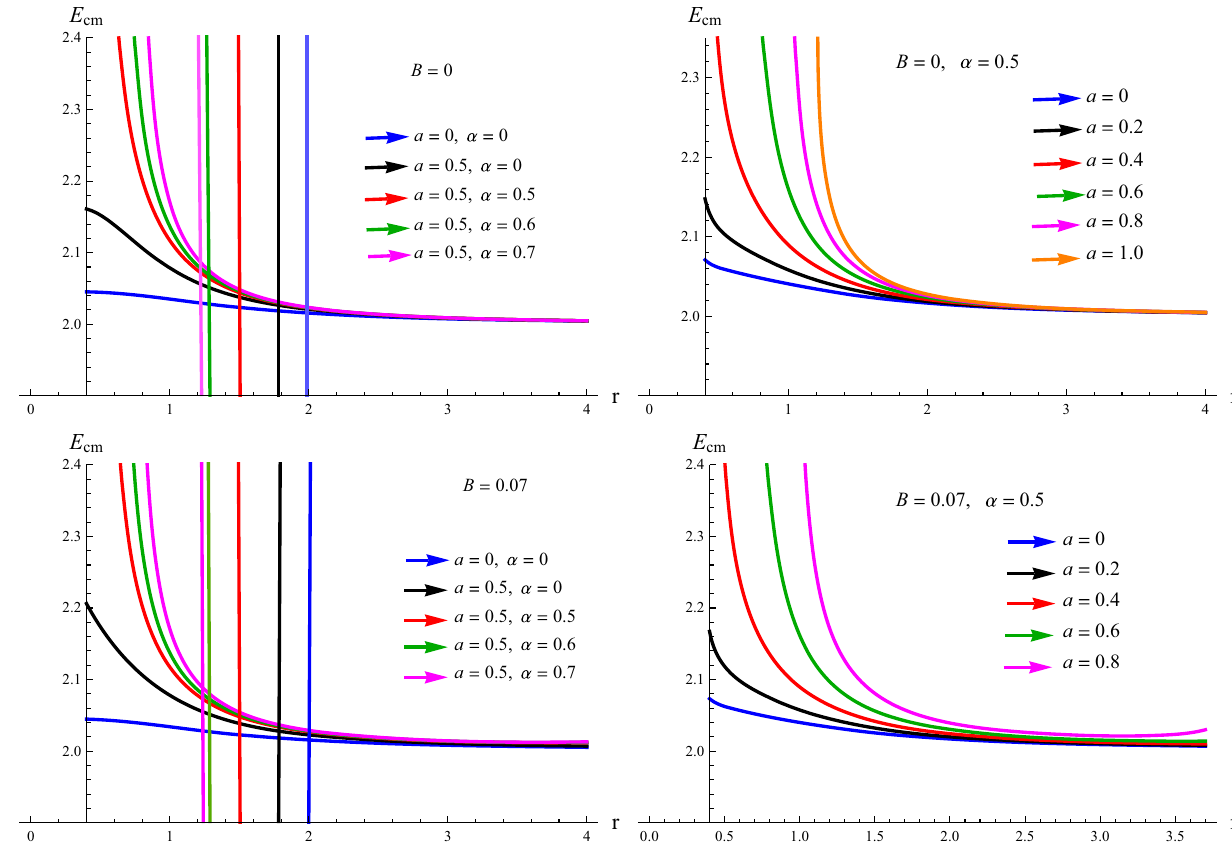
Fig. 5 The CME with respect to r for L 1 = 1 and L 2 = 1 . 5. Here, the vertical lines are event